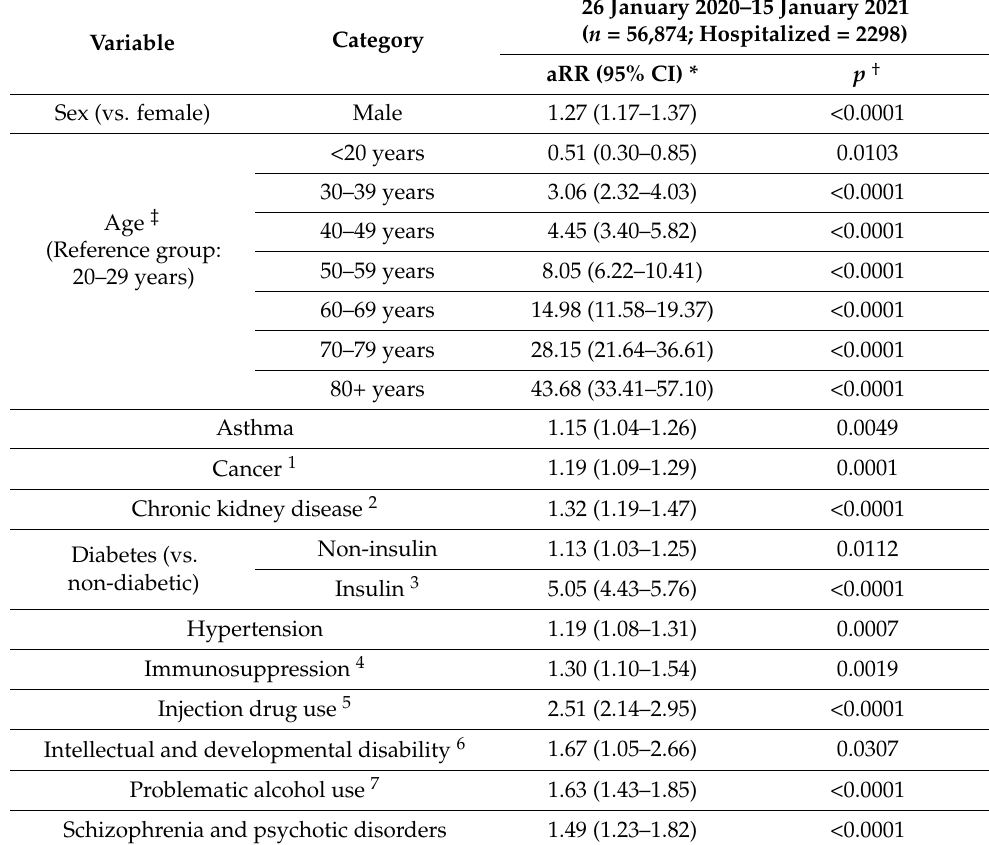
Table 2. Factors associated with hospitalization status in multivariable Poisson regression analysis with robust error variance among confirmed cases, BC COVID-19